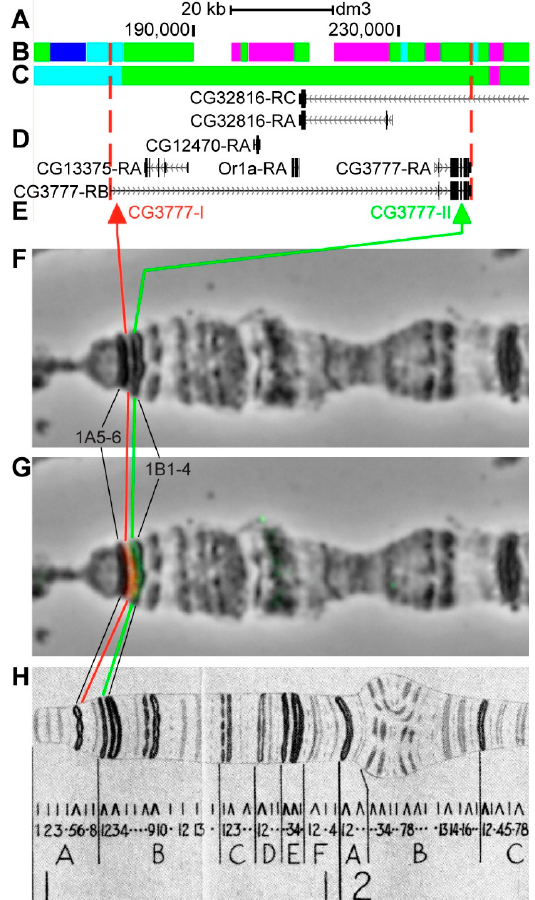
Figure 6. Localization of the CG3777 gene in the 1AB region (the gene is bound by red dotted lines). ( A ) the scale (kb) and genomic coordinates (bp); ( B ) the four chromatin-state model [39]; ( C ) the chromatin condensation level model [32]; ( D ) genes location (arrow lines show the gene orientation and black bars indicate the location of gene exons); ( E ) probes location; ( F ) phase-contrast micrograph of the region; ( G ) combined fluorescence in situ hybridization (FISH) signals; and, ( H ) C. Bridges’ chromosome map